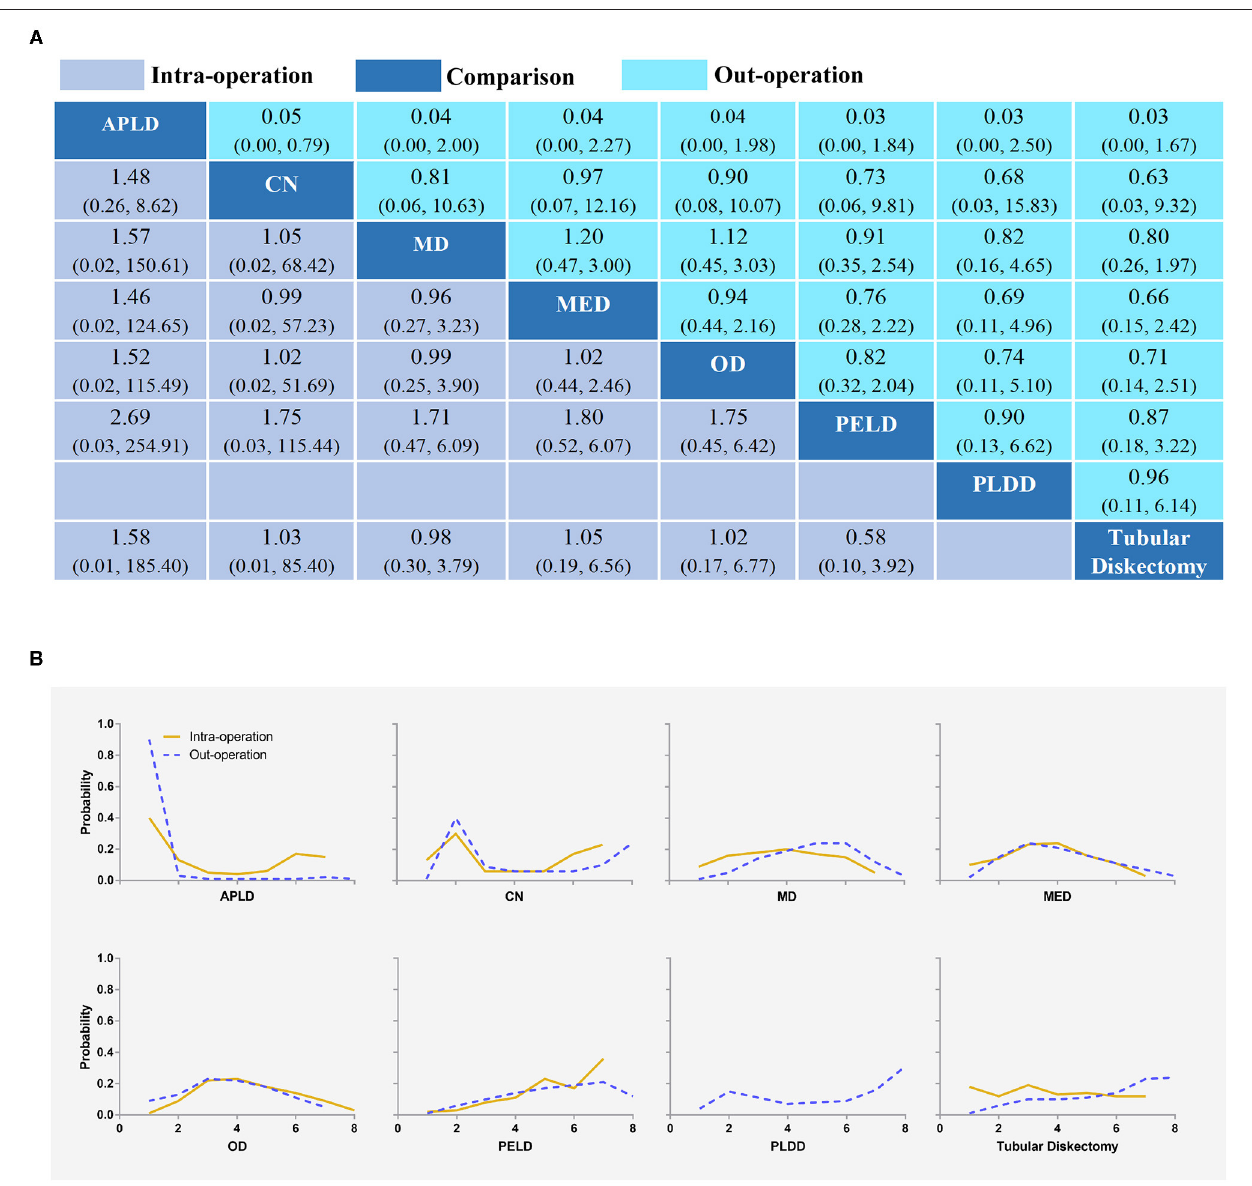
FIGURE 3 | Intra-complication and out-complication (A) and the rank possibility of intra-complication and out-complication (B) based NMA in the consistency model. Each cell of the profile contained the pooled odds ratio (OR) and 95% credibility intervals for disability change; significant results were in bold. APLD, Automated percutaneous lumbar discectomy; CN, Chemonucleolysis; MD, Microdiscectomy; MED, Micro-endoscopic discectomy; OD, Open discectomy; PELD, Percutaneous endoscopic lumbar discectomy; PLDD, Percutaneous laser disc